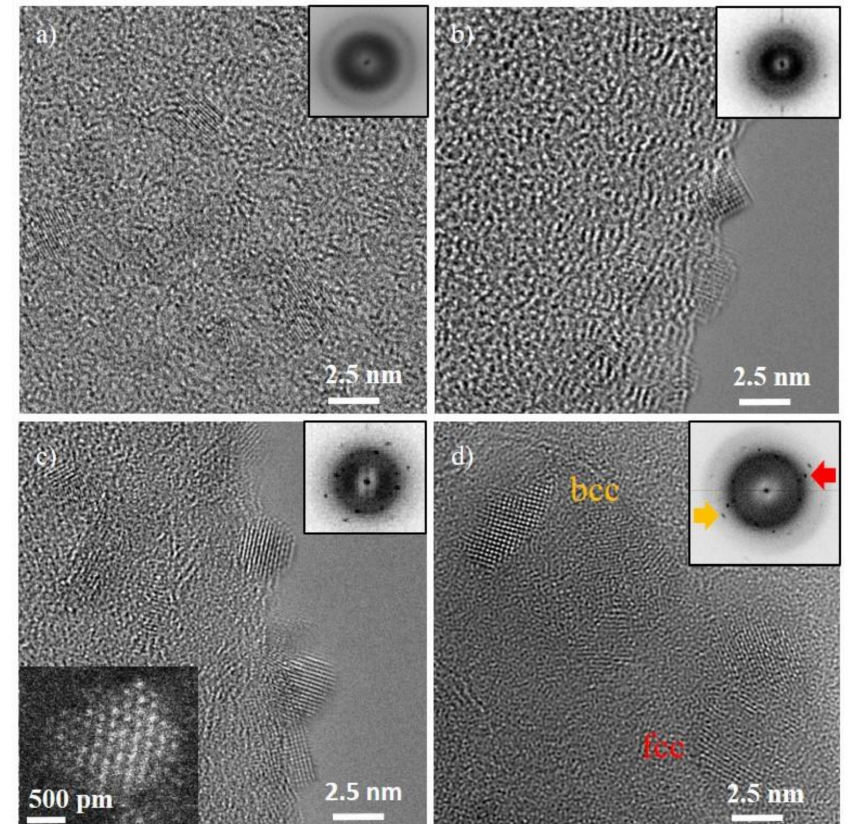
Figure 2. Results of the TEM analysis of Cr-Mn-Fe-Co-Ni NPs after ex situ crystallization at 100 ◦ C under vacuum (30 Pa) for ( a ) 2 h, ( b ) 5 h, ( c ) 10 h, and ( d ) 15 h. FFT patterns (insets) show the